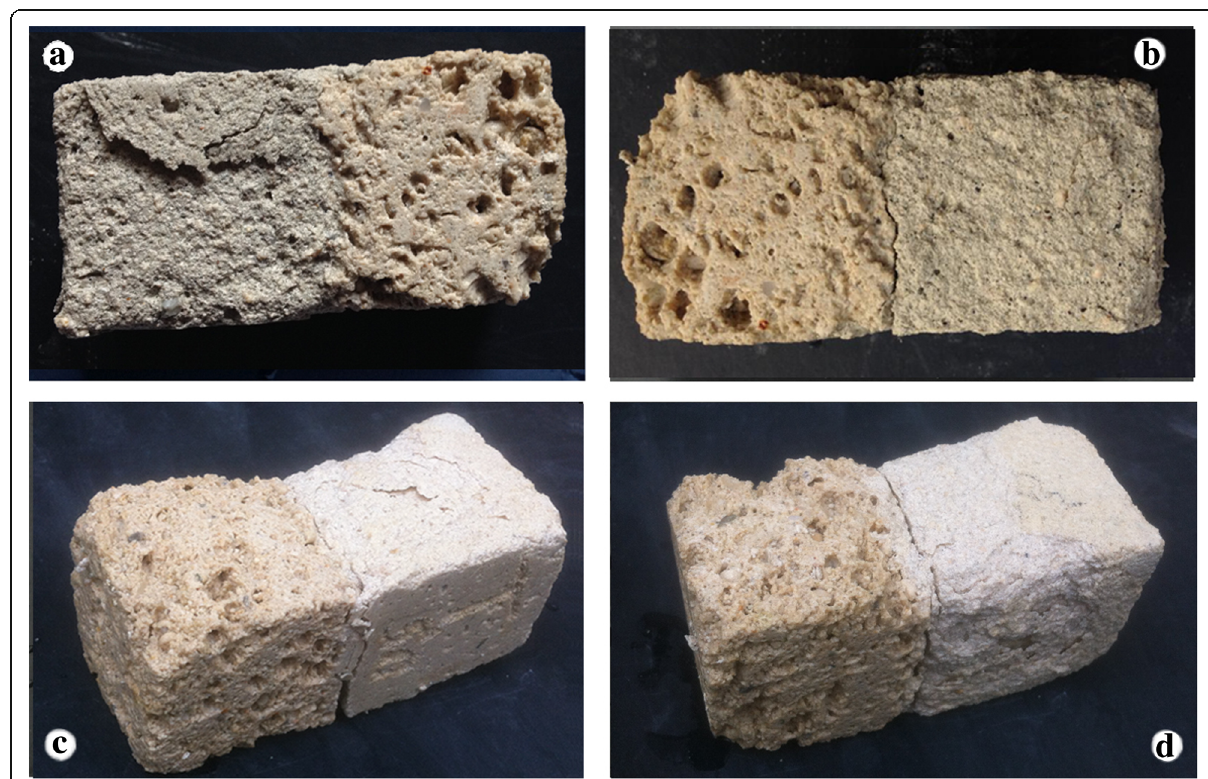
Fig. 10 Cracks observed at and parallel to stone/mortar interface due to frost damage. a T and coarse porous limestone. b Coarse porous limestone and T50. c Coarse porous limestone and K. d Coarse porous limestone and